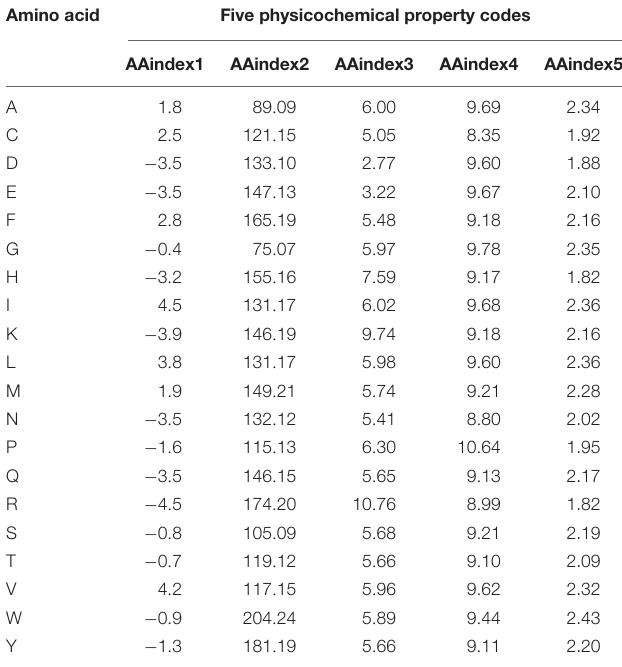
TABLE 1 | Five physicochemical property codes for each of the 20 native amino